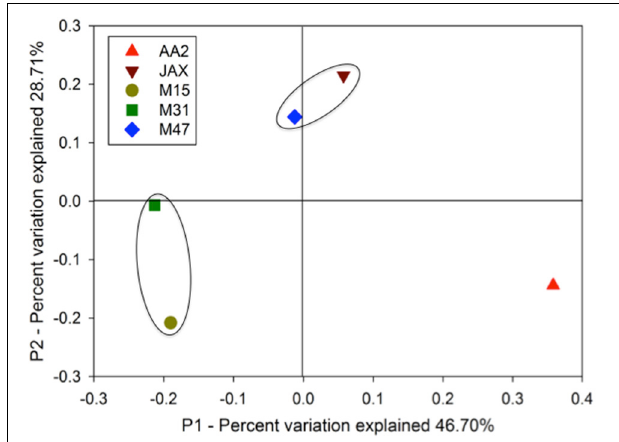
FIGURE 2 | Weighted and normalized PcoA plot of the DNRA communities in the New River Estuary. Unifrac analysis was conducted with representative NrfA OTUs in the five sediment communities. The black circles indicate the communities sharing higher composition